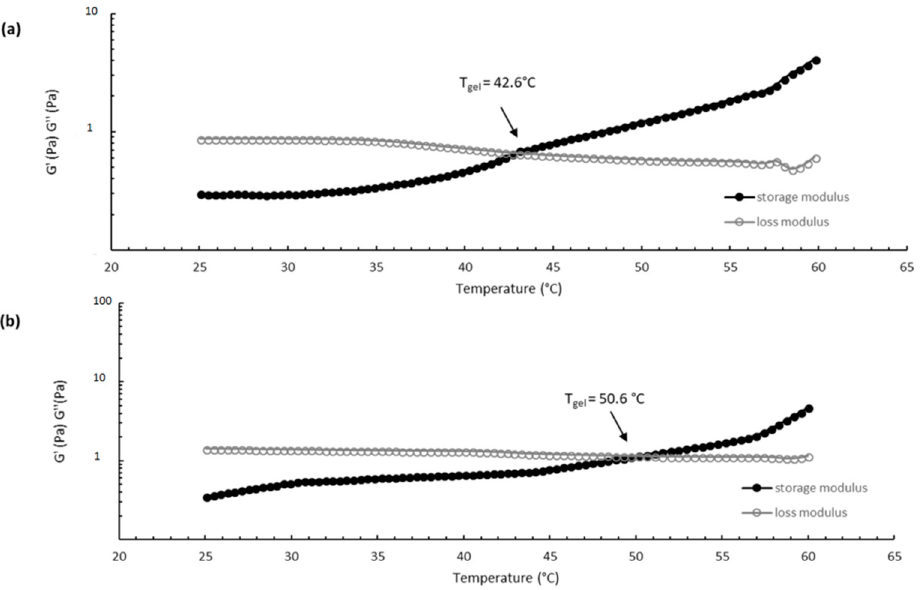
Figure 7. Temperature dependence of storage modulus (G ′ , •) and loss modulus (G ′′ , ○ ) of CS/ β GP ( a ) and CS/ β GP-NPs ( b ) formulations. The modulus value was measured between 25 and 60 °C (heating rate 5 °C/min, sampling interval = 15 s), at a stress of 0.1 Pa and frequency of 1 Hz.